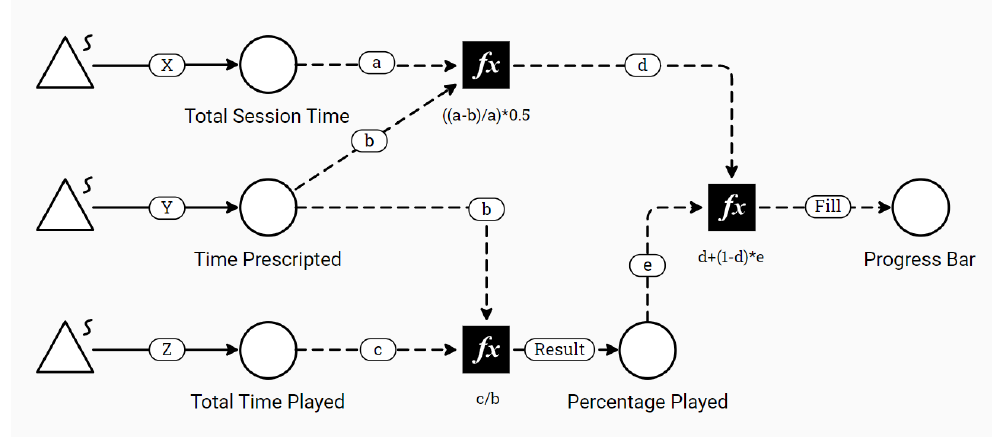
Figure 2. Game mechanics: initializing and updating the status of a progress